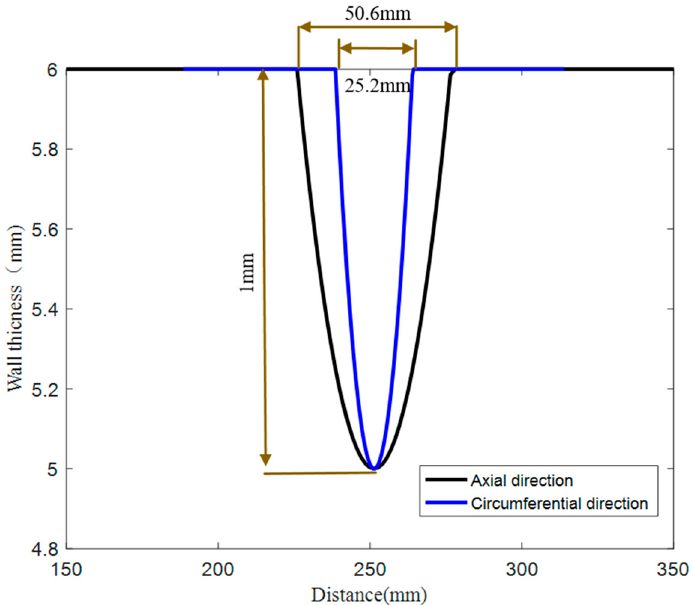
Figure 12. Process defect for elbow.